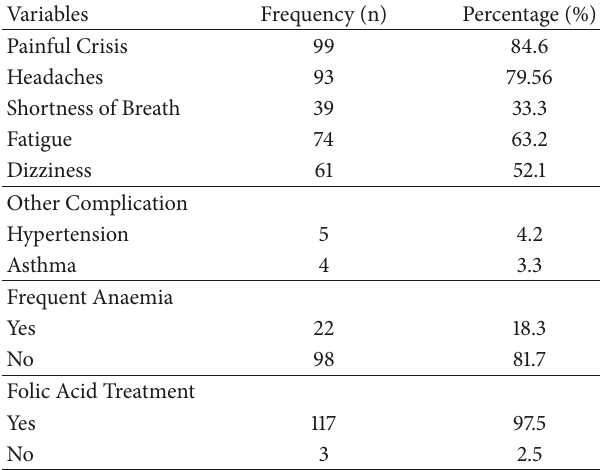
Table 1: A table presenting the clinical data of